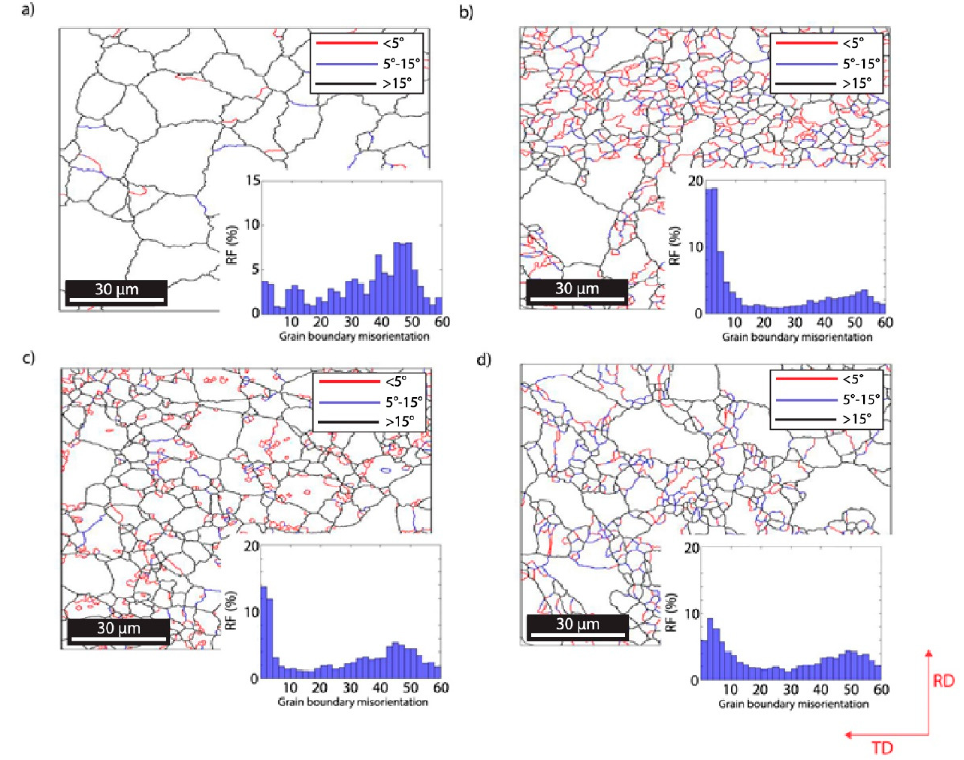
Figure 10. Grain boundaries classification map with misorientation histogram for ( a ) initial condition, ( b ) one RCS cycle, ( c ) two RCS cycles, ( d ) four RCS cycles. Here, it was observed the correlation between the misorientation boundaries and the RCS cycles.